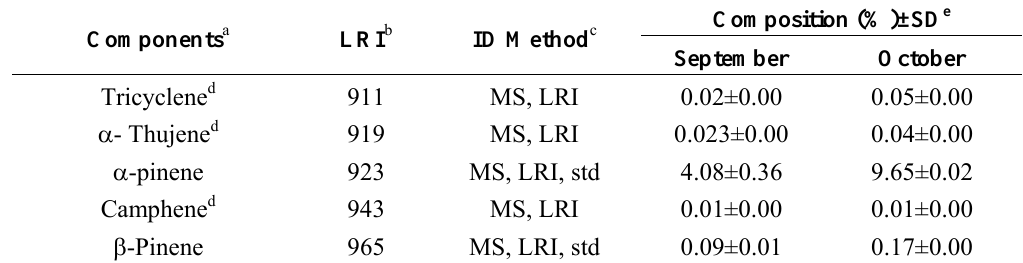
Table 4. Composition of the berries essential oil of Portuguese